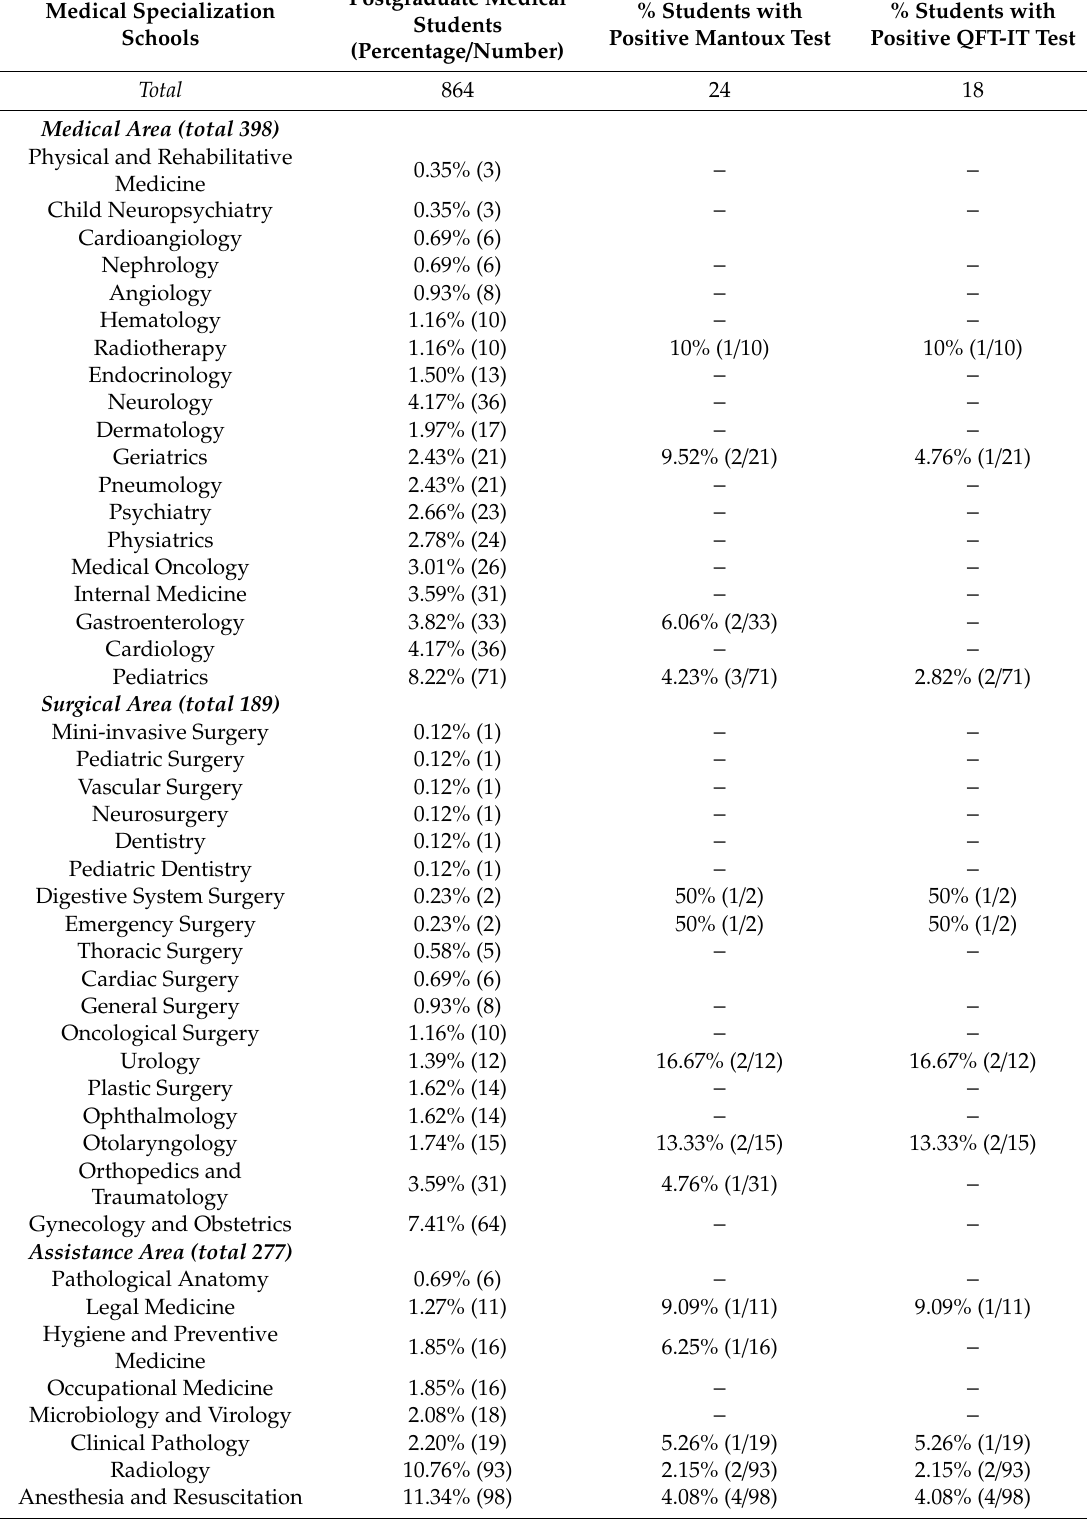
Table 3. Postgraduate students with LTBI for all medical specialization